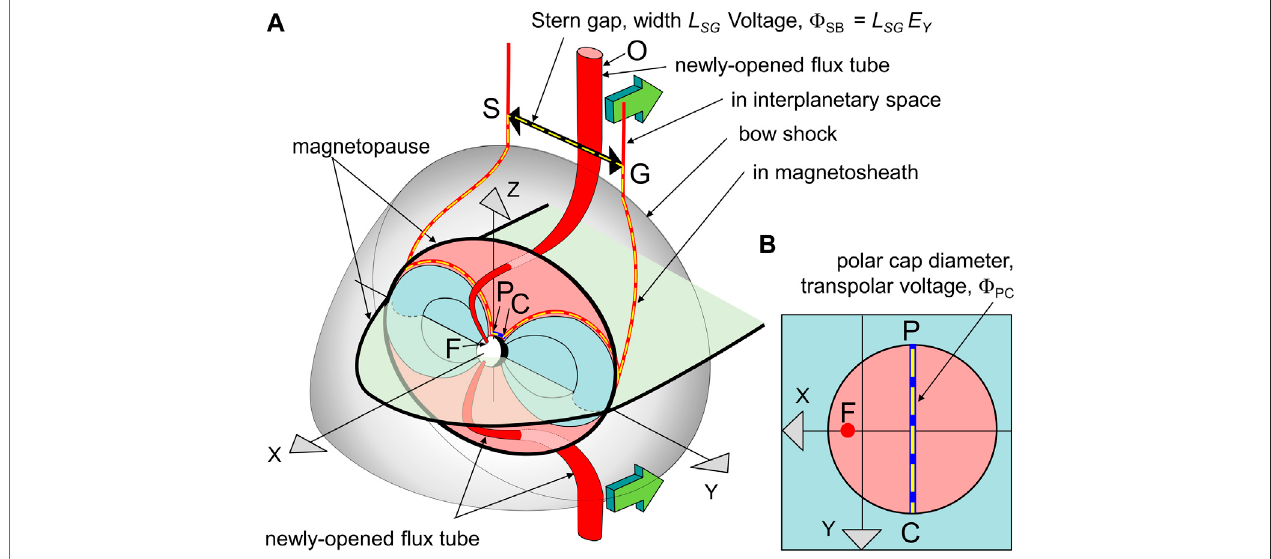
FIGURE 2 | Schematic illustrating how interplanetary voltages and electric fi elds are decoupled from those in the ionosphere by the inductive effects of growth or decay ofmagnetic fl uxes threading parts ofthe magnetosphere: in thiscase thelobe fl ux isgrowing during a substorm growth phase asnewly-opened fi eld lines like OF are appended to the tail lobe by the solar wind fl ow (green arrows) and so thread the loop PSGC, shown by the yellow dashed line, that is fi xed in the XYZ GSM frame shown. Part (A) is a view of the magnetosphere from the northern hemisphere, mid-afternoon sector and pink and light blue areas show, respectively, open and closed fi eld lineareas in the GSE YZ plane. Part (B) islooking down on the northern hemisphere polar cap and, again, pink and light blue areas show, respectively,open and closed fi eld line areas. Red lines are selected open fl ux